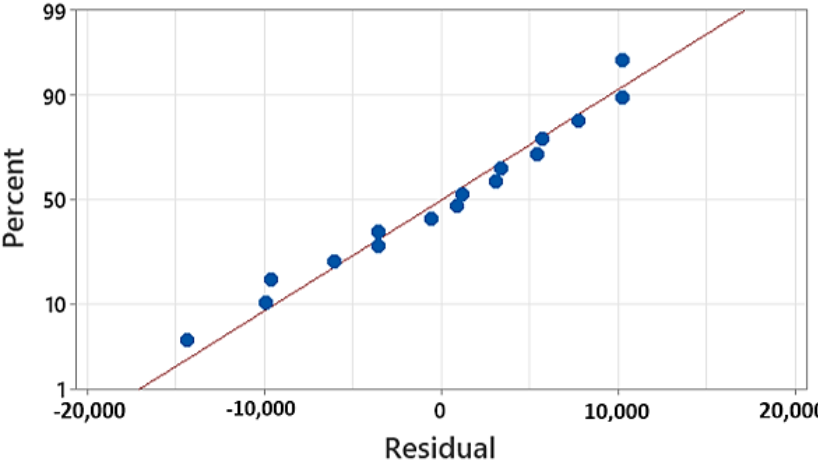
Figure 8. Residual plot for energy measured.